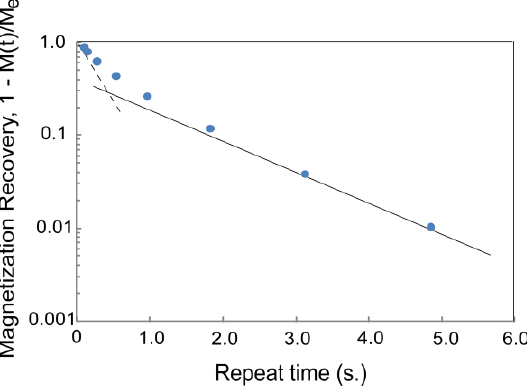
Figure A2. Observed relaxation for hydrogen deuteride molecules in zeolite-13X for 1 molecule per sodalite cage at 5.0 K. Two distinct relaxation times are observed, corresponding to the two-bath relaxation